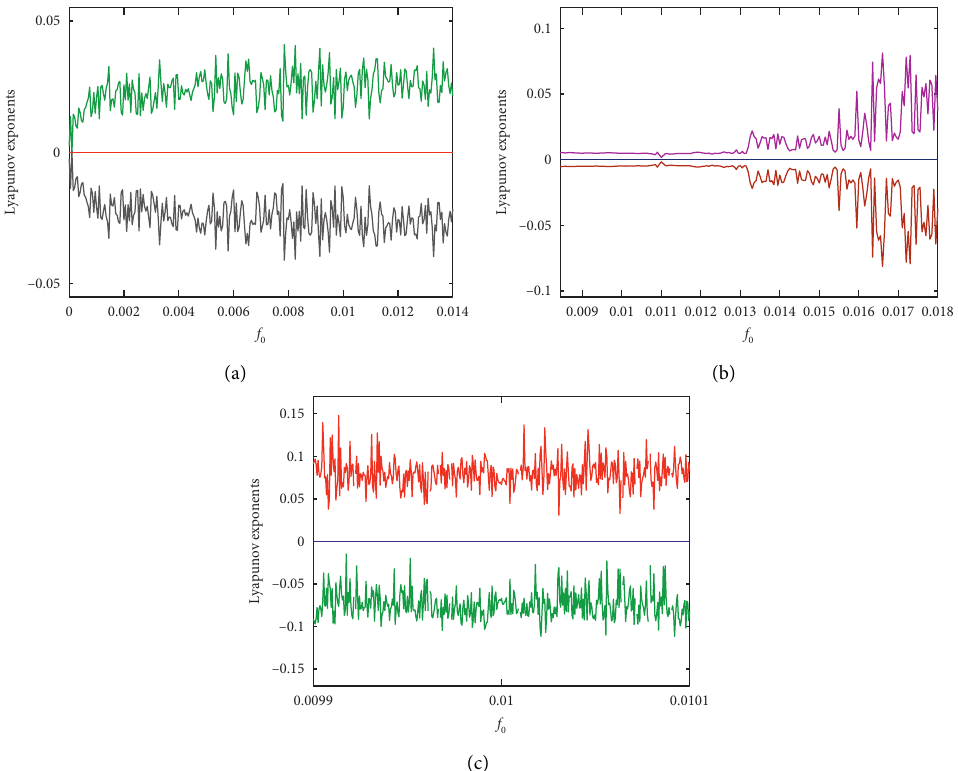
Figure 3: Lyapunov exponents of system (13) of chaotic attractors corresponding to (a) Figure 2(a), (b) Figure 2(c), and (c) Figure 2(d).